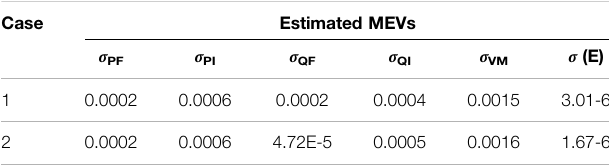
TABLE 4 | Estimated MEVs of the IEEE 30-bus system ( N LME =